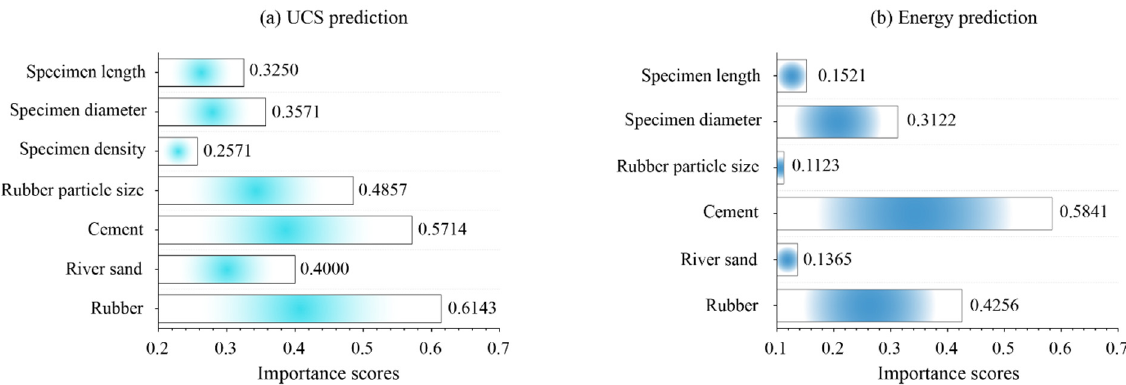
Figure 9. The Taylor diagrams of all models for predicting the UCS and ETR of novel material.